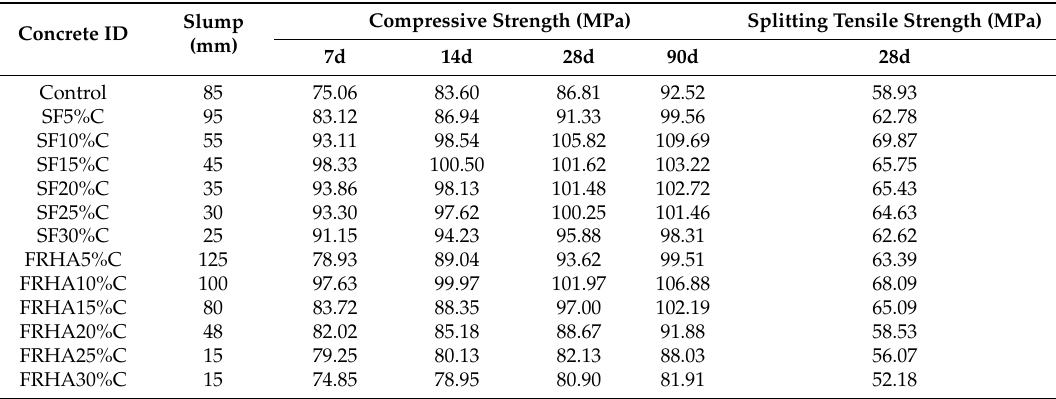
Table 5. Slump, compressive strength, and splitting tensile strength of